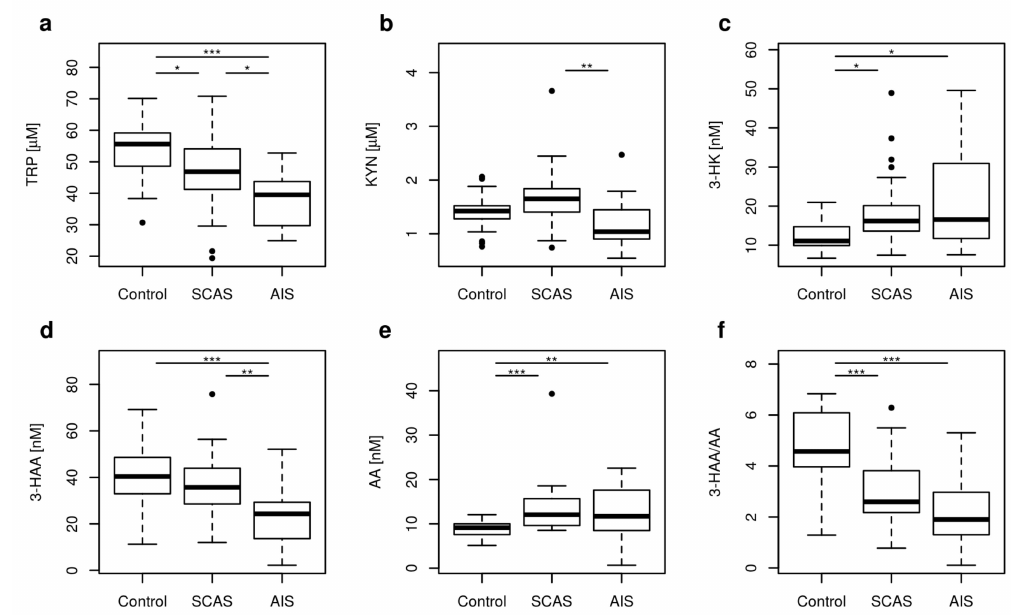
Figure 2. Plasma concentrations of kynurenine pathway metabolites changed in neurovascular disease. Theconcentrationsorratiosofmetabolitesintheplasmaofthecontrols(control),